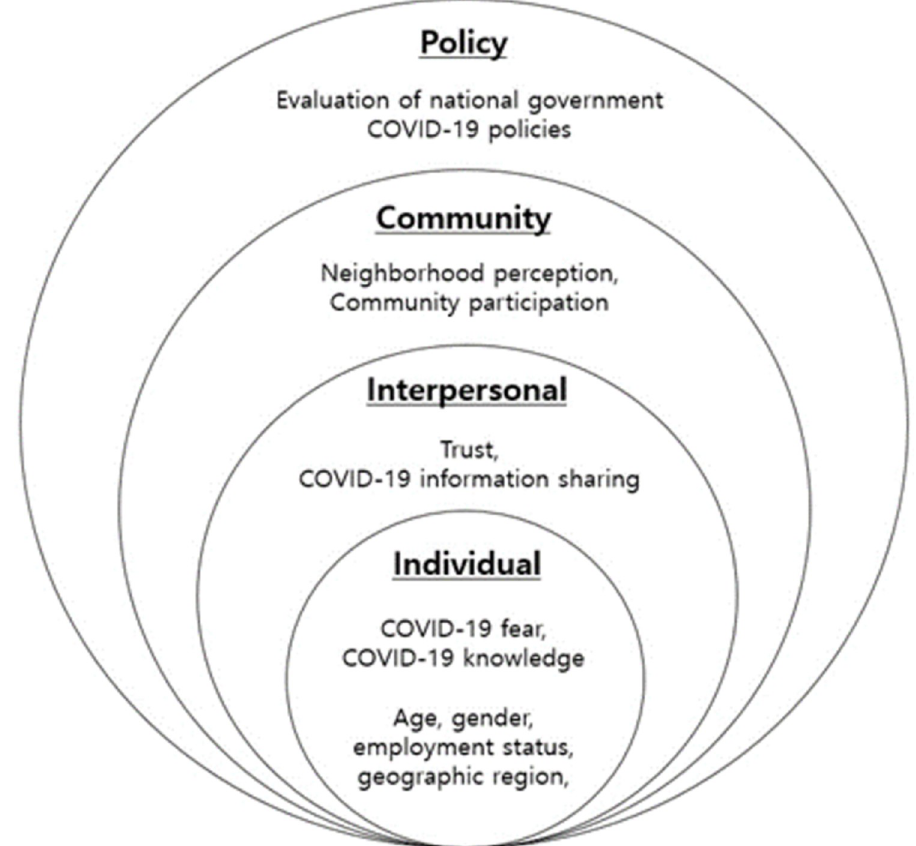
Fig 1. Social-ecological model for COVID-19 preventive